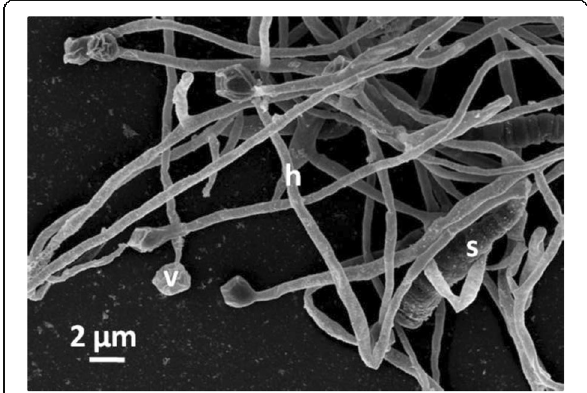
Fig. 2 Scanning electron micrograph of strain NRRL B-16219 after growth for 4 weeks in liquid DPM medium at 28 °C showing hyphae (h), vesicles (v) and sporangia